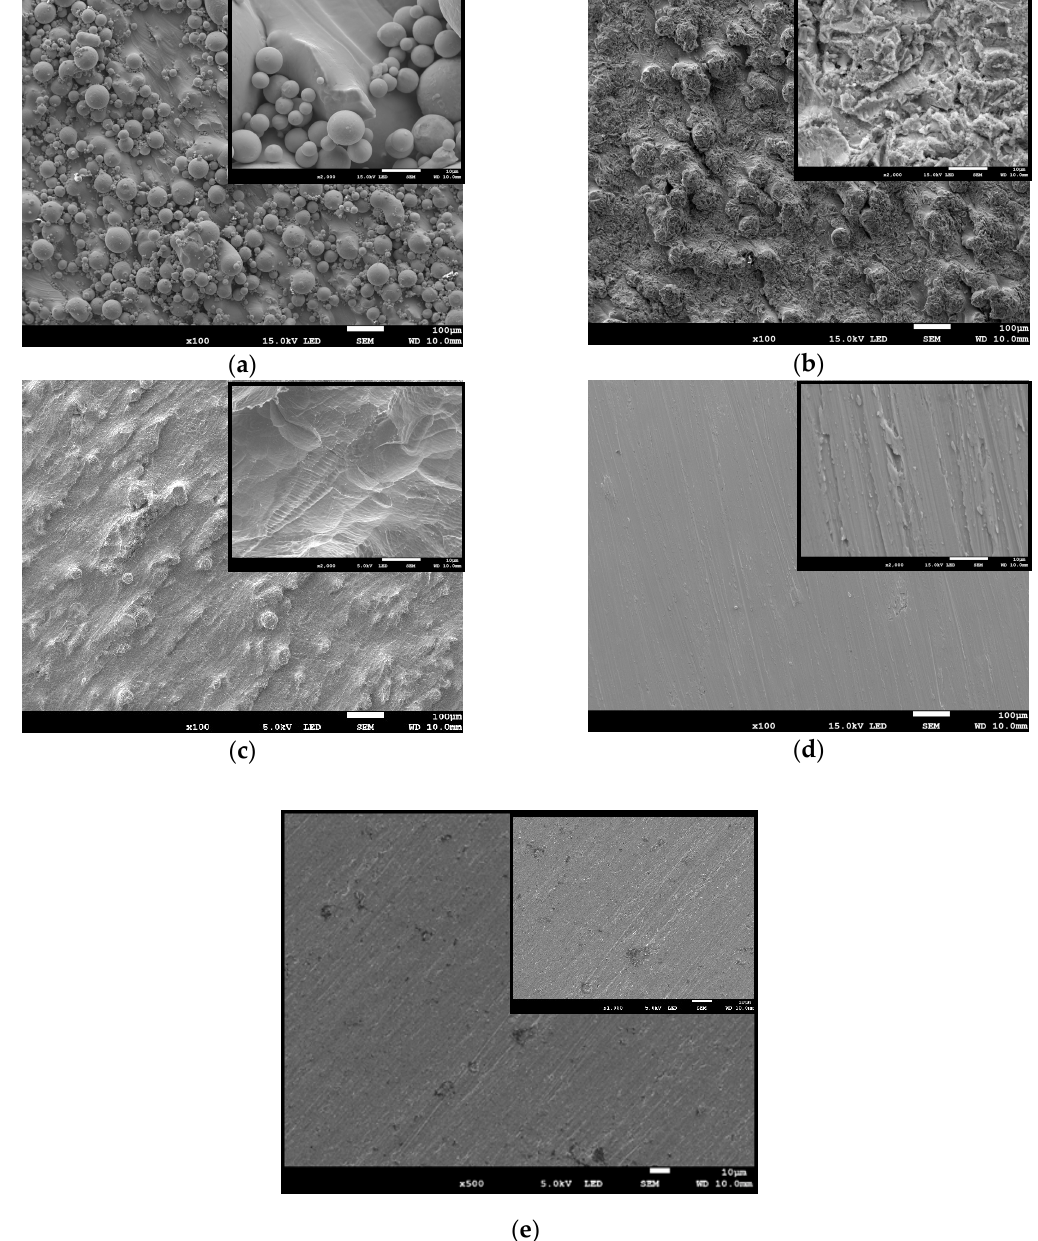
Figure 3. SEM images of the titanium alloy specimen surfaces after different surface treatments and at two different magnifications ( × 500 and × 2000): ( a ) Untreated SLM; ( b ) Sandblasted SLM; ( c ) Etched SLM; ( d ) Ground SLM; and, ( e ) Solid bar (the presented pictures are representative for five specimens).